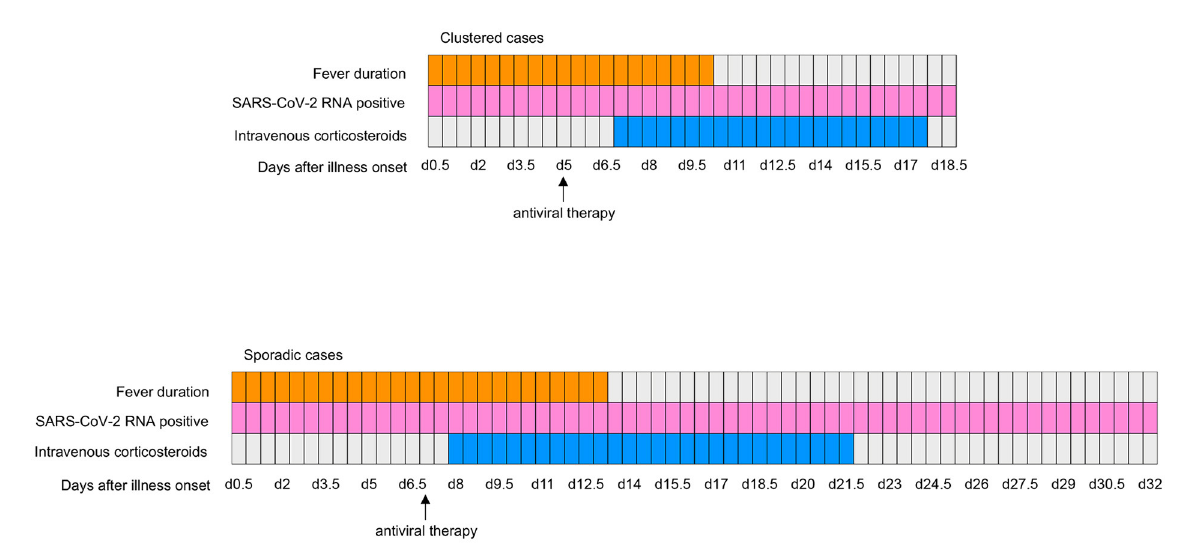
FIGURE1 Clinical courses of major symptom and treatments and duration of viral shedding from illness onset in patients hospitalized with COVID-19. SARS-CoV-2, severe acute respiratory syndrome coronavirus 2; COVID-19, coronavirus disease 2019.